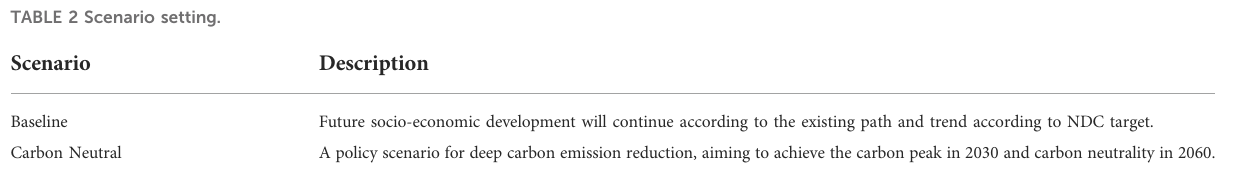
TABLE 2 Scenario